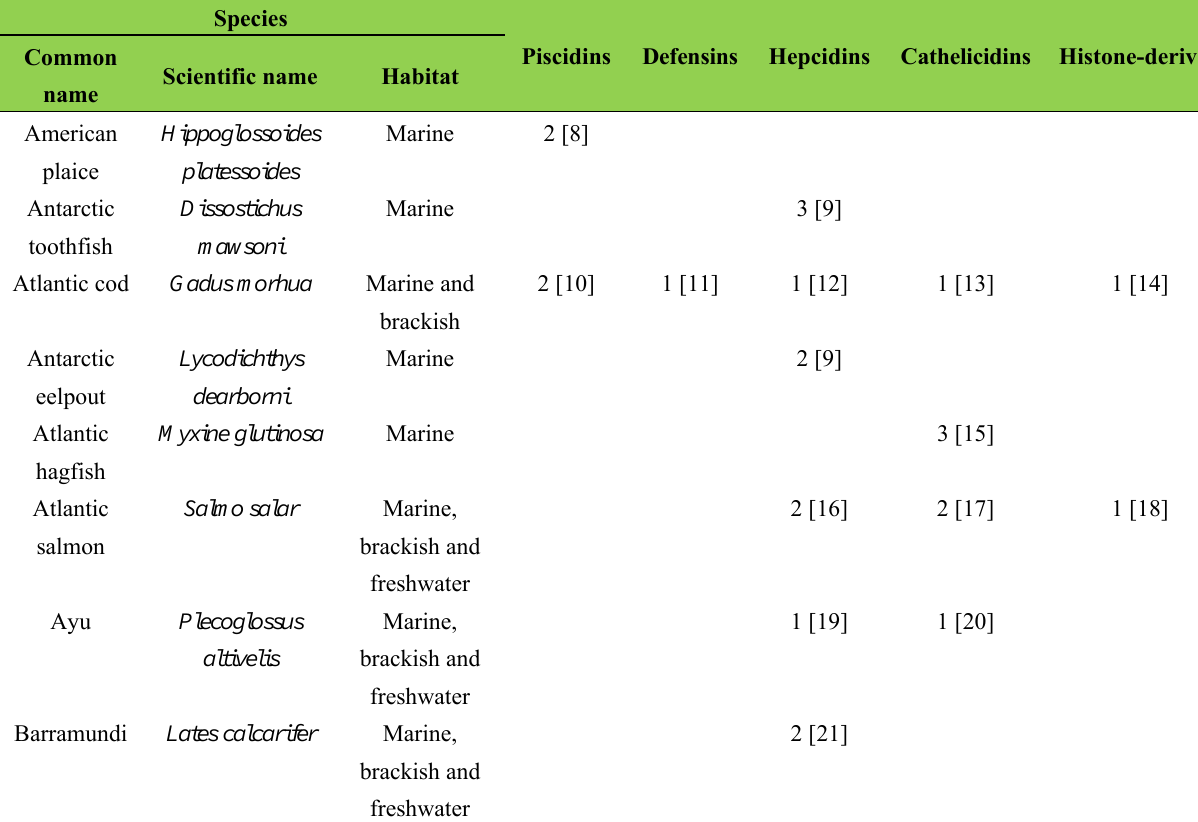
Table 1. Characterized antimicrobial peptides from fish, by species. Listed is the number of peptides of each family [reference].